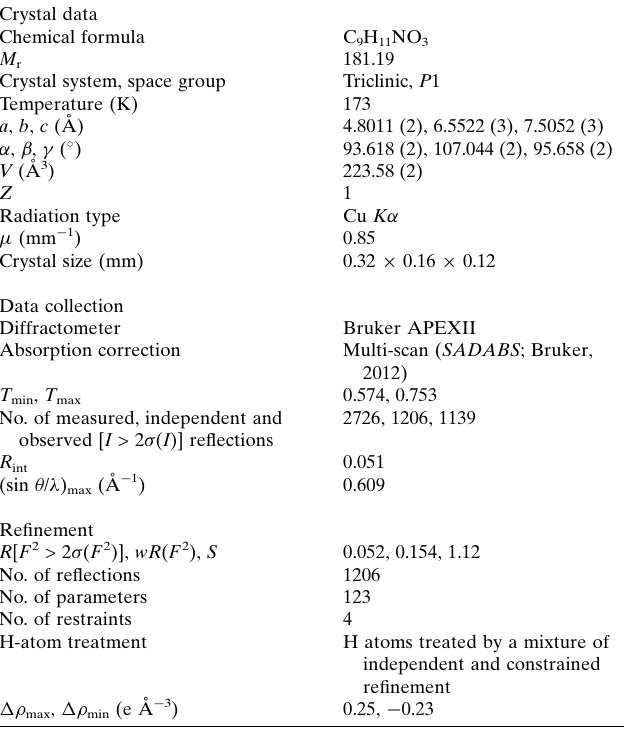
Table 2 Experimental details. Crystal data Chemical